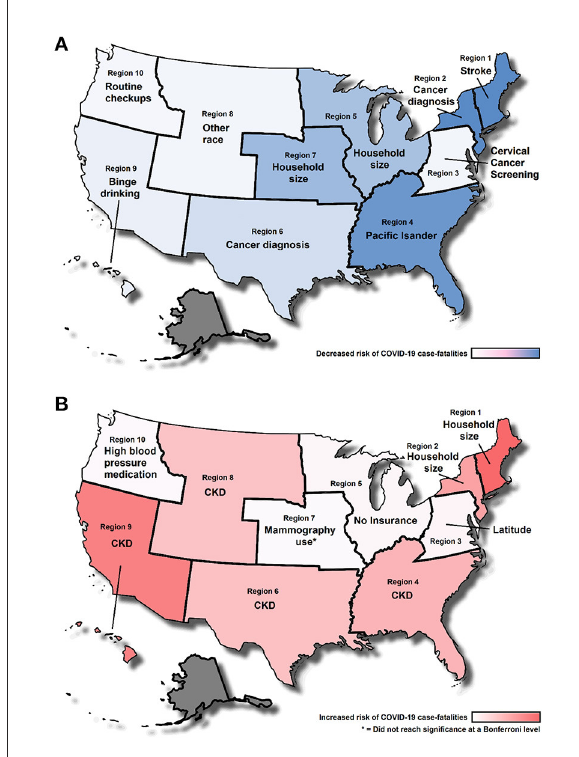
FIGURE3 Top county level factors associated to COVID-19 case-fatalities for each United States Department of Health and Human Services regions. (A) Top factors associated with reduced case fatalities. (B) Top factors associated with increased case-fatalities. Shading indicates the effect size across regions (adjusted by COVID-19 Community Vulnerability Index, CCVI). Alaska was excluded from the analysis because of differences in their county level reporting. CKD, Chronic Kidney